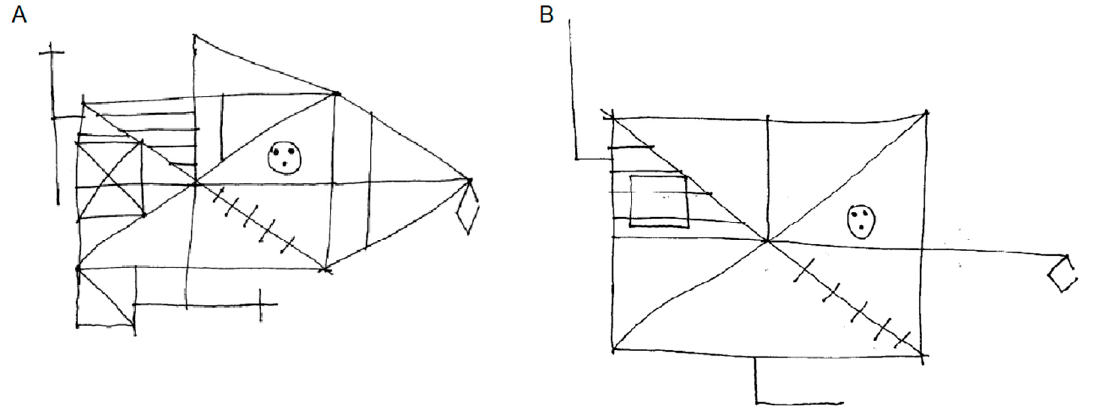
Figure 1. PL518 ′ s performance on the Rey Complex Figure Test. ( A ): Copy. ( B ): three-minute recall.